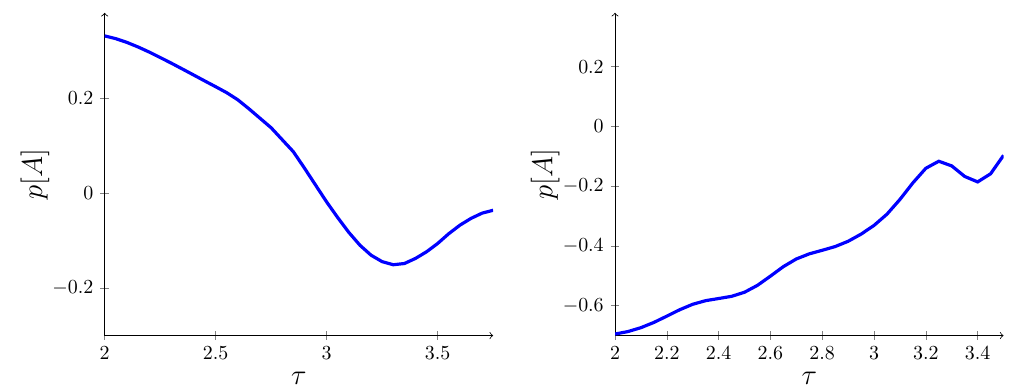
Figure 8 . The exponent p [ A ( (cid:28) )], de(cid:12)ned as the solution to relation (4.10) for the rapidity distribu- tion amplitude A , as a function of proper time (cid:28) , for collisions with ( w and ( w ; w (cid:0) ) = (0 : 1 ; 0 : 25) +